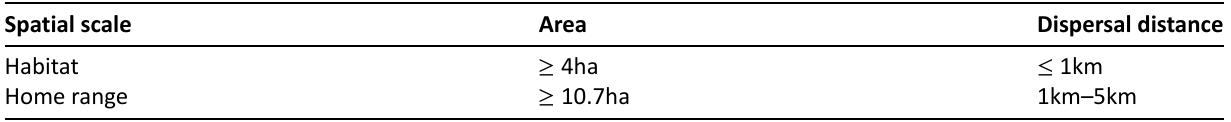
Table 1. Key parameters about the dispersal ability of Eurasian jays, obtained from Conway and Fuller (2010), Dyer (1995), Gómez (2003) and Rolando